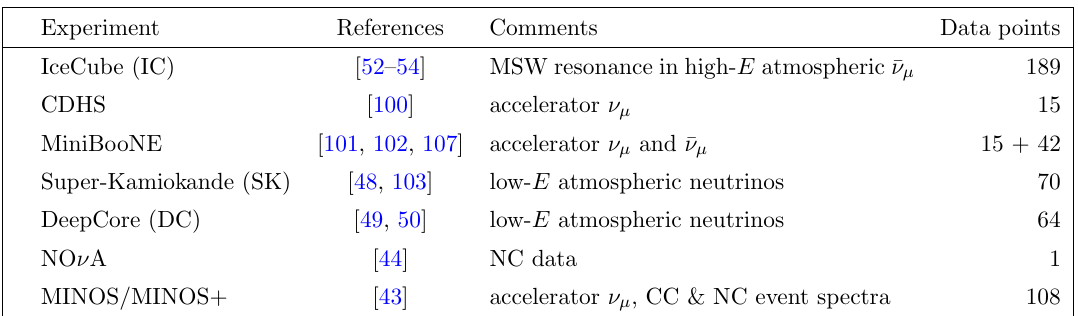
{ ) { ) (cid:23) (cid:22) ! ( (cid:23) (cid:22) disappearance analysis. The total